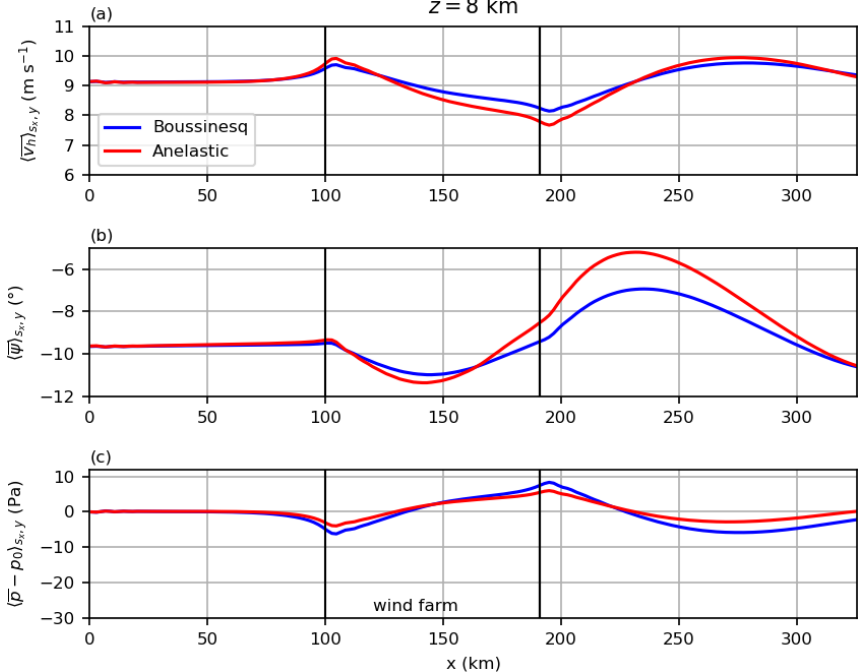
Figure A3. Horizontal wind speed, wind direction and relative perturbation pressure at 8km height for both approximation types.